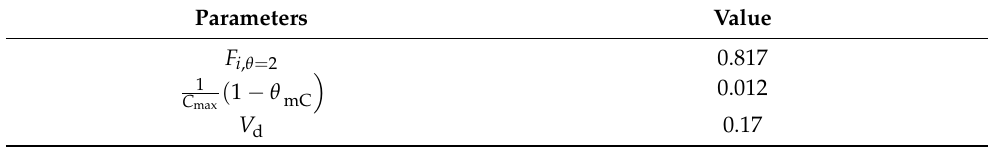
Table 3. Dead volume